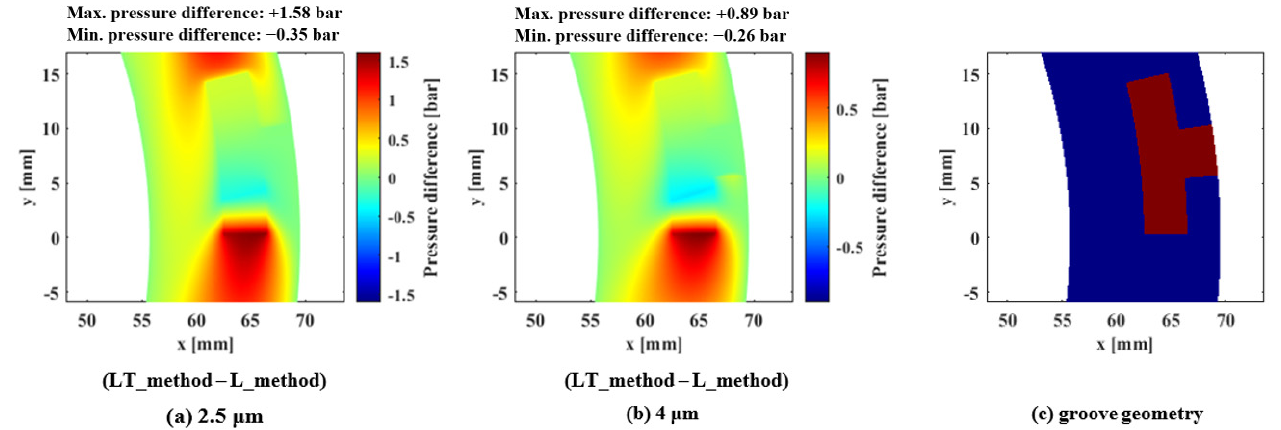
Figure 13. Pressure difference between the LT_method and the L_method for a fluid film of 2.5 μ m ( a ) and 4 μ m ( b ) corresponding to T-groove geometry ( c ). Outer pressure = 6 bar. ( a ) and 4 µ m ( b ) corresponding to T-groove geometry ( c ). Outer pressure = 6 bar.